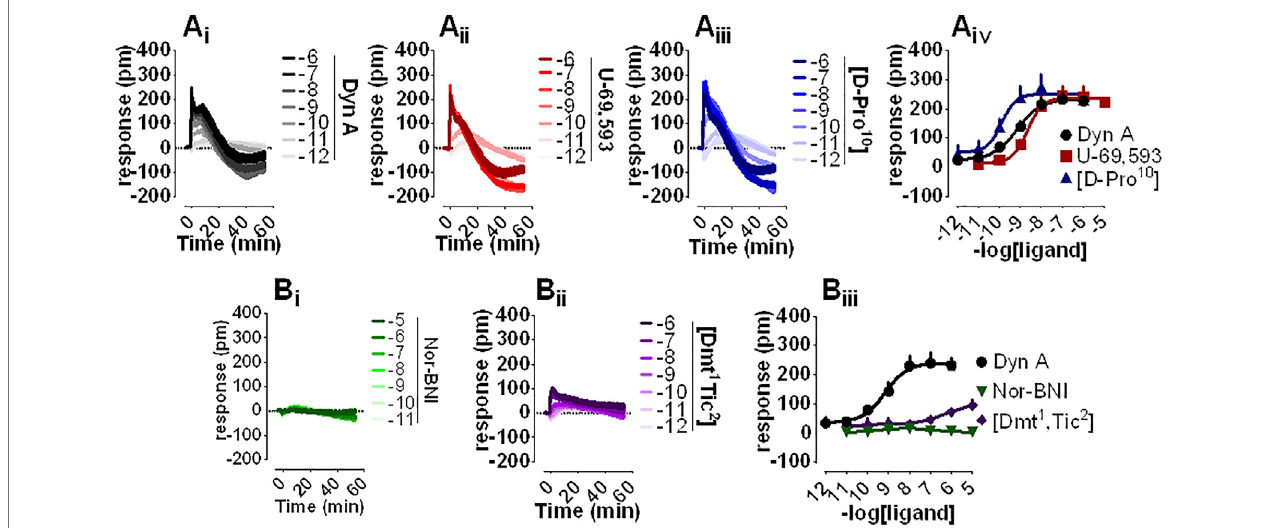
FIGURE 2 | DMR experiments in CHO cells stably expressing the human kappa opioid receptor (A i-iii ) Averaged kinetics of increasing concentrations of Dyn A, U- 69,593, and [D-Pro 10 ], and (A iv ) corresponding concentration-response curves (B i-ii ) Averaged effects of Nor-BNI and [Dmt 1 ,Tic 2 ], and (B iii ) corresponding concentration-response curves. Data represented are mean +sem of four to seven independent experiments performed in duplicate and Emax were analyzed statistically using one-way analysis of variance followed by Dunnett ’ s test for multiple comparisons.